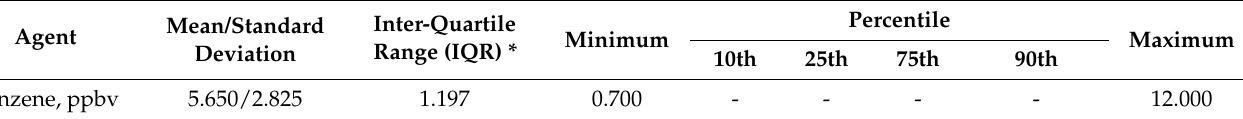
Table 3. Indoor benzene distribution